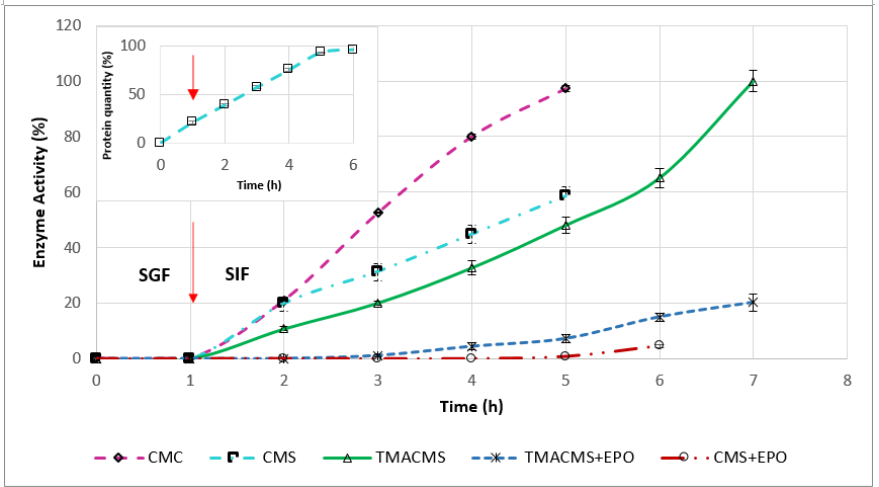
Figure 8. Release profile of catalase from the tablets with CMC, CMS, TMACMS, CMS + EPO, and TMACMS + EPO as excipients all containing 30% catalase ( n = 3). Tablets of each formulation were incubated separately in 50 mL of SGF (37 °C, 50 rpm). After 1 h, the tablets were transferred to 50 mL of SIF, and the activity of catalase was measured every hour. The arrow marks the transition of the tablets from SGF to SIF. Insert: Release profile of the protein quantity from the tablets of CMS containing 30% catalase.